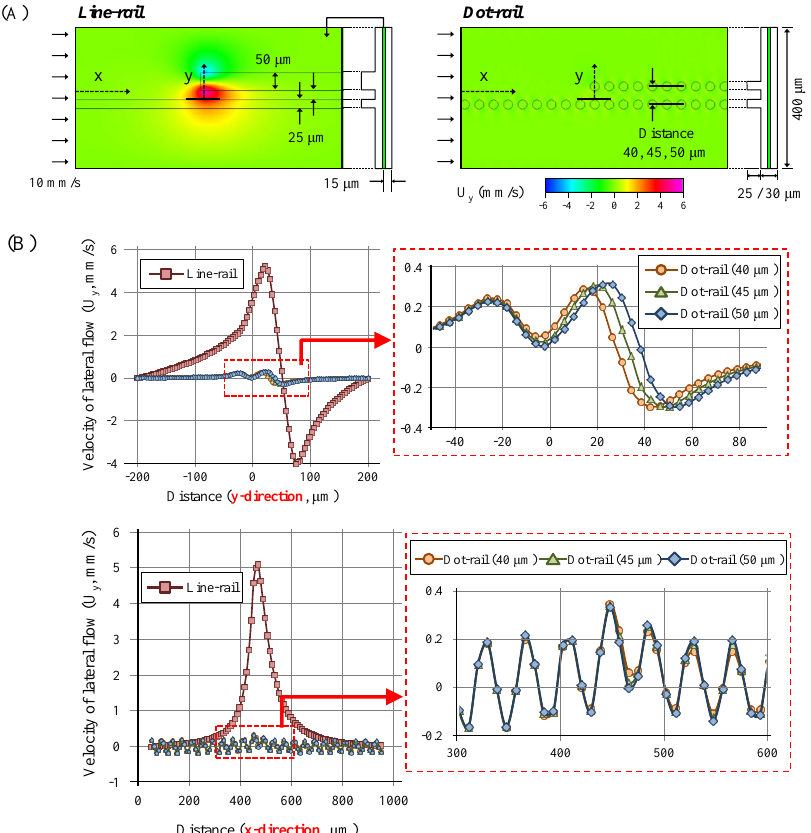
Figure 2. Computation analysis results of the sorting structures. ( A ) Conditions of the analysis and visualization of the flow field. ( B ) Velocity distributions of the side flow in the x- and y-direction at the sorting